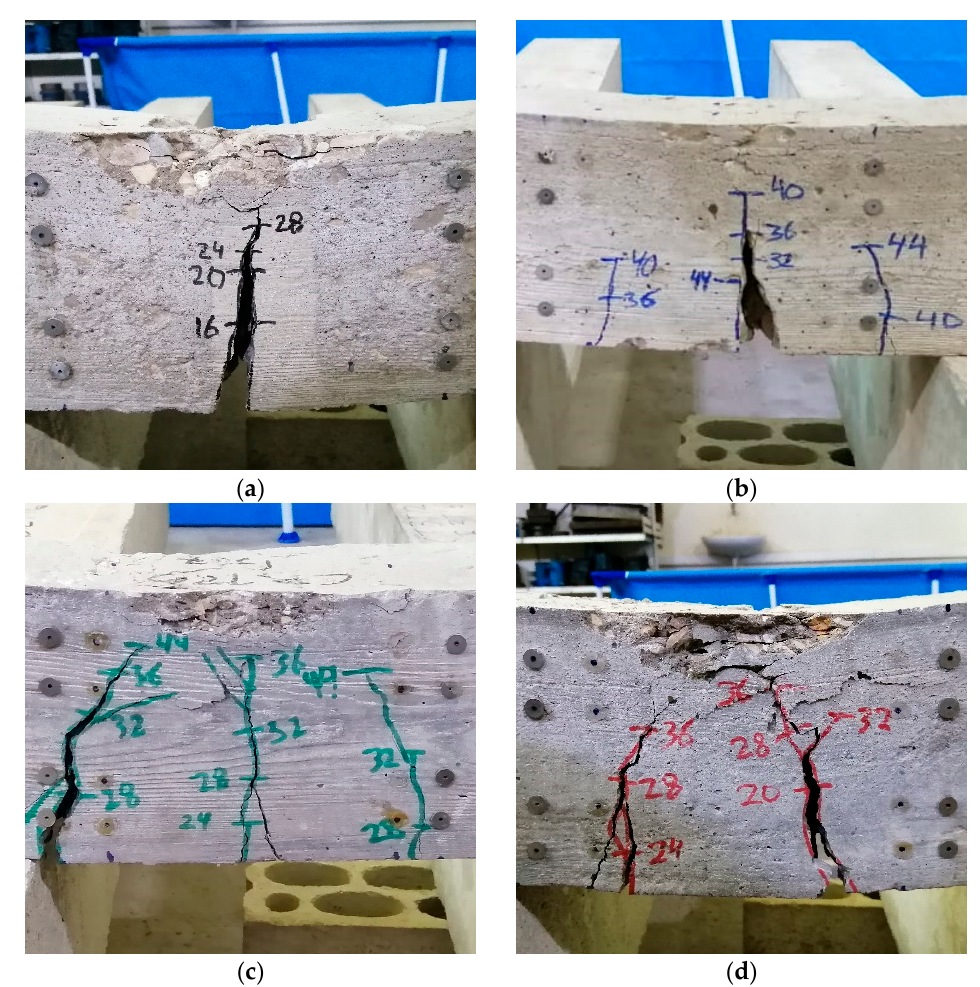
Figure 10. Failure mode and crack propagation for beam ( a ) CRT-0, ( b ) CRT-10, ( c ) CRT-20, and ( d ) CRT-30.